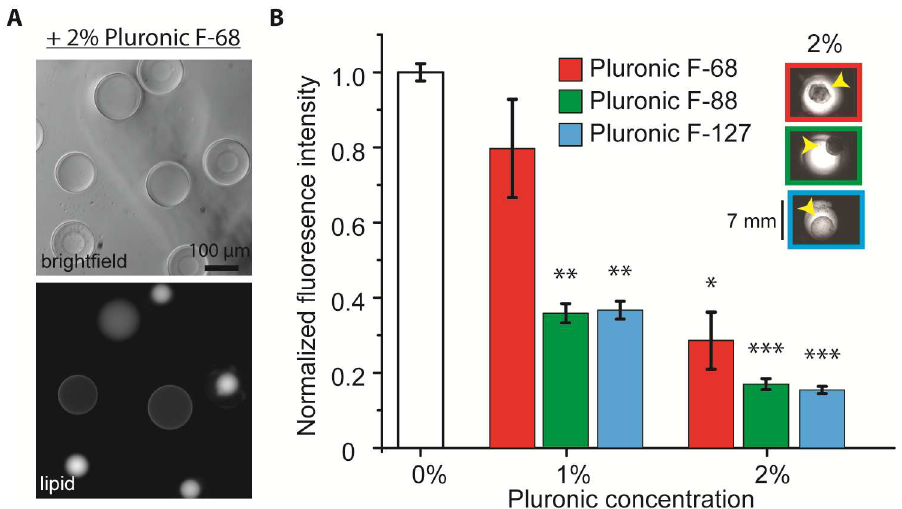
Fig 5. Pluronic surfactant also caused the formation of aggregate and reduced CFE activity. (A) Brightfield(top) and fluorescence (bottom) images of doubleemulsiontemplatedvesicles (without HeLa lysate) with 2% PluronicF-68. (B) eGFP expressionin HeLa CFE at different concentrations of surfactants for PluronicF-68 (red), F-88 (green), and F-127 (blue), unpairedt test comparing with 0%; * : p < 0.01; ** : p < 0.001; *** : p < 0.0001. Inset shows brightfieldmicrowellimages at 2% of surfactant concentration with yellow arrowhead pointingto the